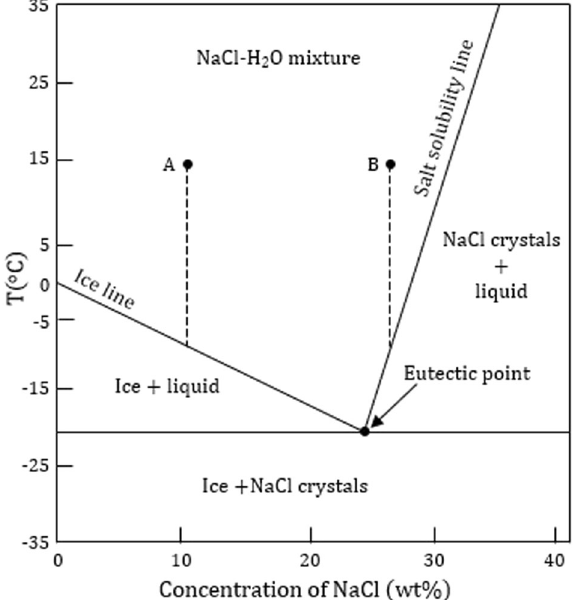
Fig. 7 NaCl-H 2 O mixture equilibrium phase diagram 41 . The solidi fi cation of the NaCl-H 2 O mixture follows the ice line or salt solubility line depending on the initial